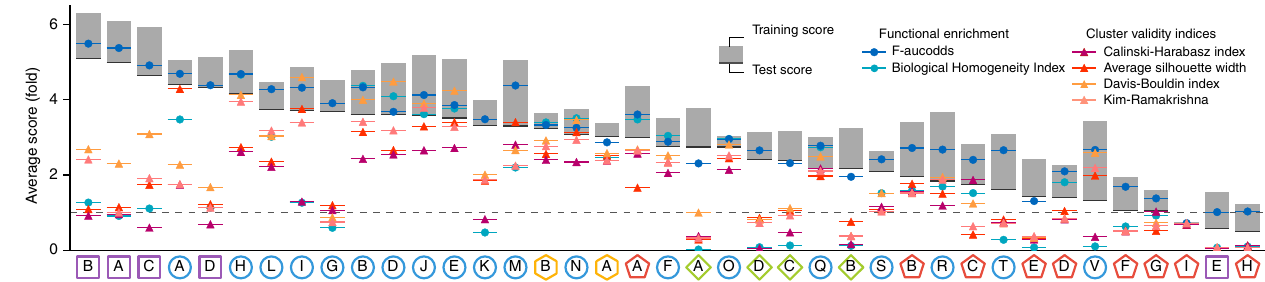
Fig. 3 Effect of automatic parameter estimation using four different cluster validity indices and two measures based on functional enrichment on the performance of top module detection methods. Shown are changes in test scores after parameter estimation (either using measures based on functional enrichment in blue or cluster validity indices in red – orange), averaged over datasets and module de fi nitions, of the top module detection methods in